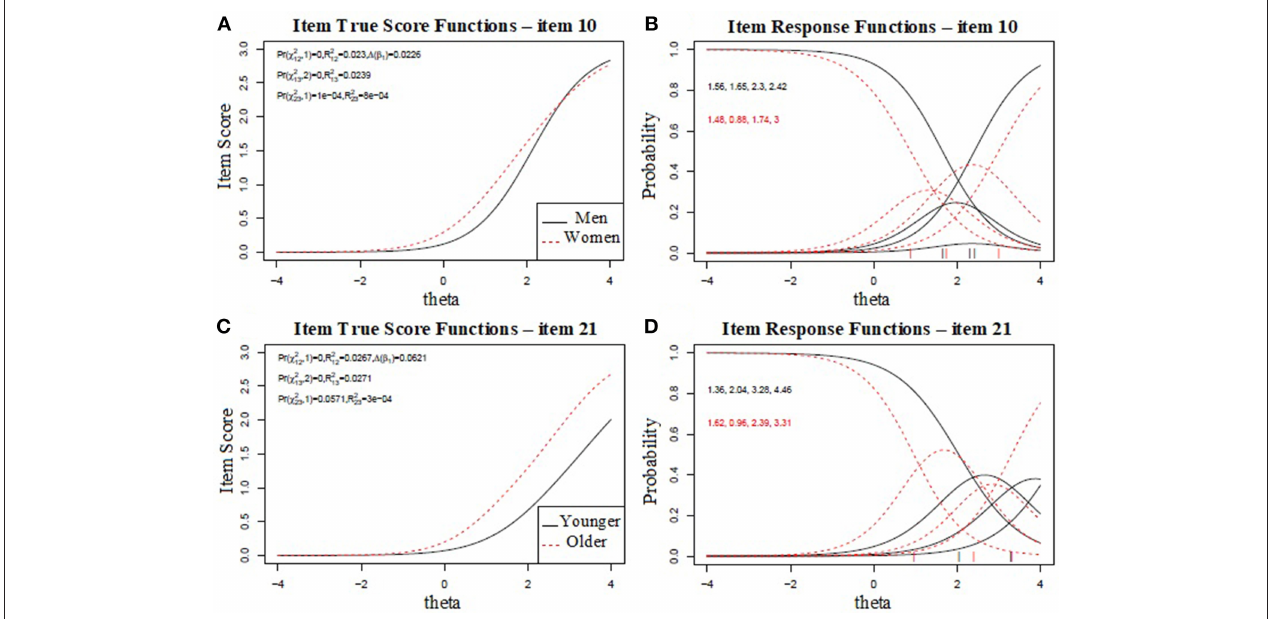
FIGURE 1 | The first (A) and third (C) plots represent the true score (item response theory score) of the college student sample on differential item functioning (DIF), for item #10 and item #21. The second (B) and fourth (D) plots show the item characteristic curves for items #10 and #21. The curves show the probability of endorsing a particular